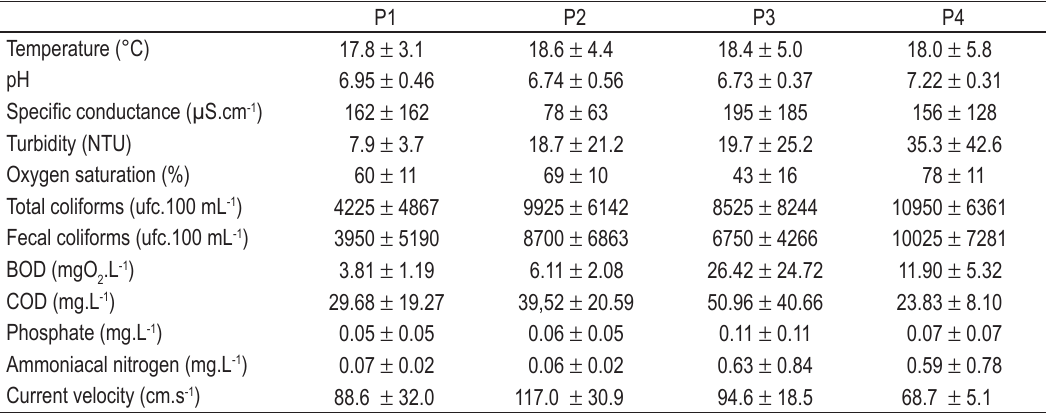
Table 2. Environmental variable values (mean ± standard-deviation) during the study period in the four sampling sites in Cascavel Stream, Guarapuava, Paraná State.